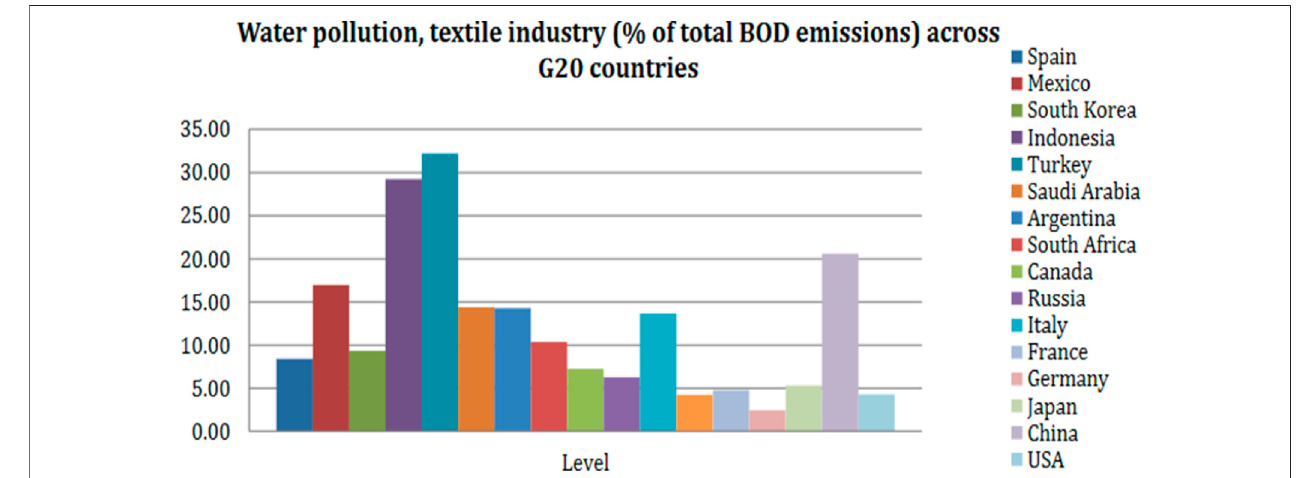
FIGURE 2 | Material industry pollution of